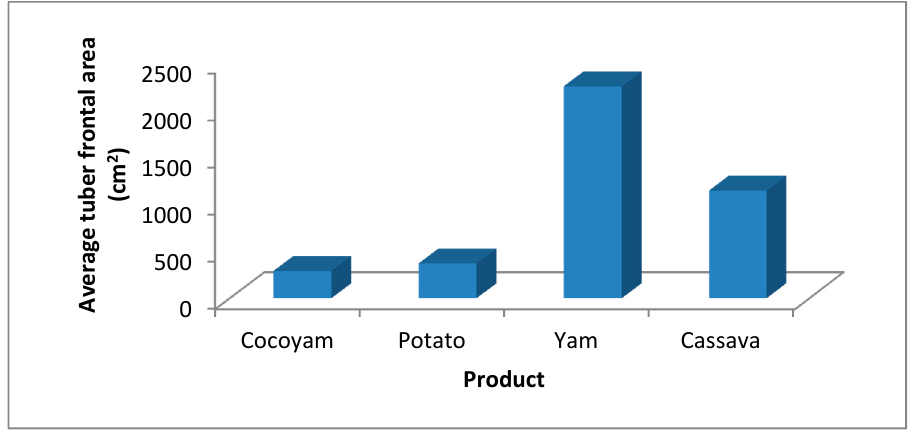
Figure 8. Comparison of tubers’ frontal area.